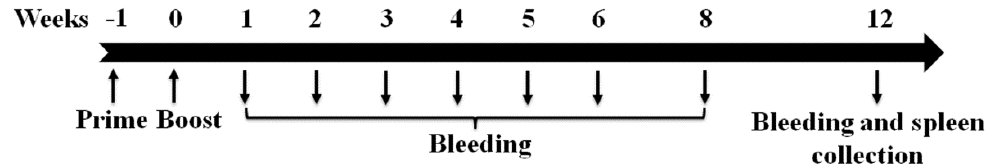
Figure 1. Timeline of the immunization and blood collection. BALB/c mice were immunized with high and low doses of RBD-hFc, RBD-mFc and S1-hFc proteins mixed with 0.5 mg/mL aluminum hydroxide adjuvant each and boosted 1 week later. Blood were taken at 1, 2, 3, 4, 5, 6, 8 and 12 weeks after the second vaccination. Spleens were collected after euthanizing.